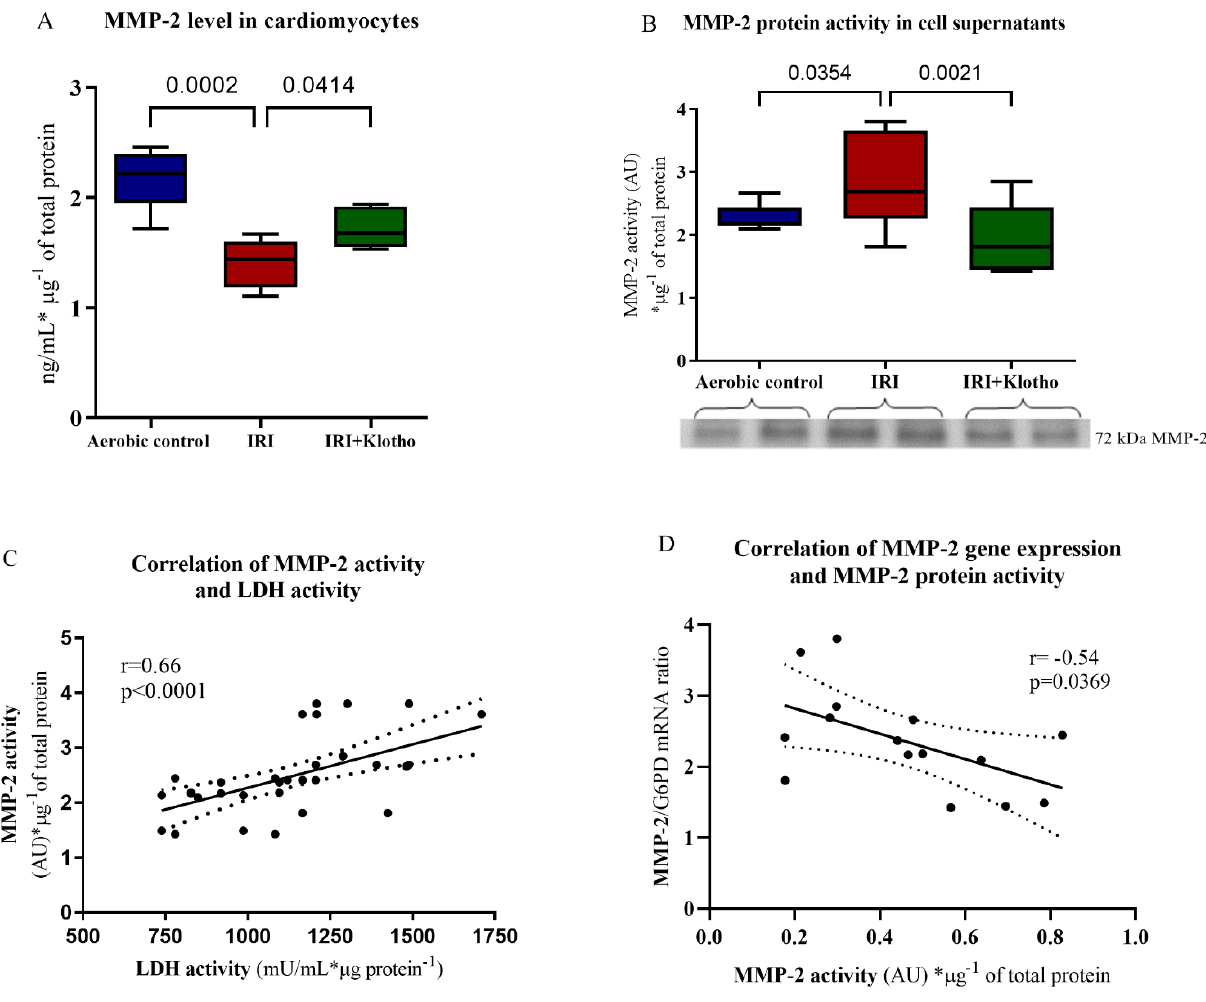
Figure 4. ( A ) The concentration of MMP-2 protein in cell homogenates; n aerobic = 6; n IRI = 6; n IRI+Klotho = 5; ( B ) The activity of 72 kDa MMP-2 protein in cell supernatants (S1). The activity of MMP was examined by zymography, expressed in AU and normalized to the total protein concen- tration; n aerobic = 10; n IRI = 10; n IRI+Klotho = 12; ( C ) Correlation of MMP-2 activity and LDH activity; ( D ) Correlation of MMP-2 gene expression and MMP-2 activity; lines—mean; dotted lines—standard error; AU—arbitrary unit; G6PD—glucose-6-phosphate dehydrogenase; LDH—lactate dehydroge- nase; mU/mL—milli international enzyme units per milliliter; MMP—matrix metalloproteinase; boxes—25–75% percentile, whiskers—min to max +